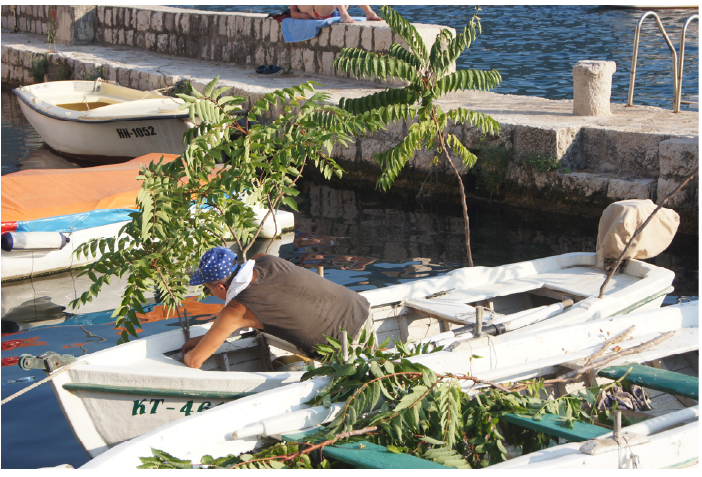
Figure 2. Preparing the boats in 2021. Photo by author.